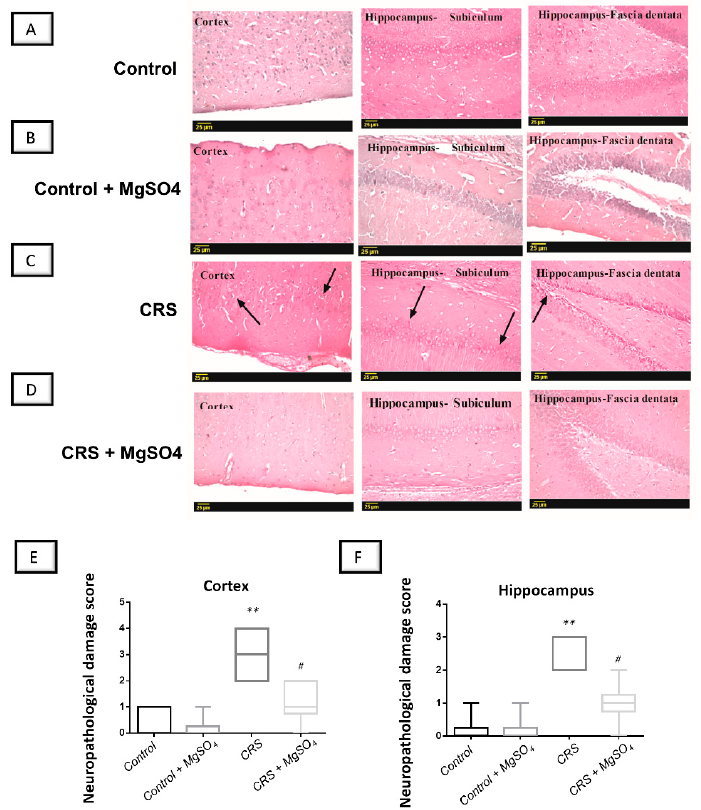
Figure 9. Effect of magnesium sulfate on brain histological alterations in rats exposed to chronic restraint stress (CRS). The brain sections were stained with hematoxylin/eosin (H/E) and were examined under light microscope (Representative micrographs; scale bar = 25 µm). Administration of magnesium sulfate counteracted the histopathological changes by CRS in the hippocampus and cortex regions in rats’ brains. ( A , B ) Microscopic investigation of brain sections revealed a normal histological structure in the control and magnesium-sulfate-treated group in the cerebral cortex alongside fascia dentata and hilus of the hippocampus. ( C ) In the CRS group, evident nuclear pyknosis (arrow) and degeneration were detected in the neurons located in the cortices and hippocampi of animals. ( D ) These alterations were attenuated by magnesium sulfate administration to the CRS-exposed rats. ( E , F ) The histopathological damage in the cortices and hippocampi of the animals, respectively, was quantified as the neuropathological damage scores. Administration of magnesium sulfate lowered the neuropathological damage scores in the cortices [H (3, 20) = 16.89, p = 0.0007] and hippocampi [H (3, 20) = 17.87, p = 0.0005] of rats exposed to CRS. The values of neuropathological scores were represented as the median with the interquartile range ( n = 6). Statistical analysis was applied using the Kruskal–Wallis test followed by Dunn’s multiple comparison post-test. Significant differences versus control animals are denoted by ** p < 0.01. Significant differences versus CRS group are denoted by # p < 0.05. CRS, chronic restraint stress; MgSO 4 , magnesium sulfate.